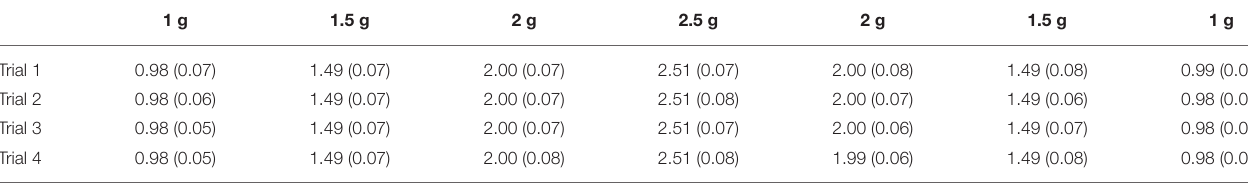
TABLE 1 | Magnitude of the local gravitoinertial acceleration (Gz) in each programmed environment in the centrifuge and during each individual lift (rows). 1